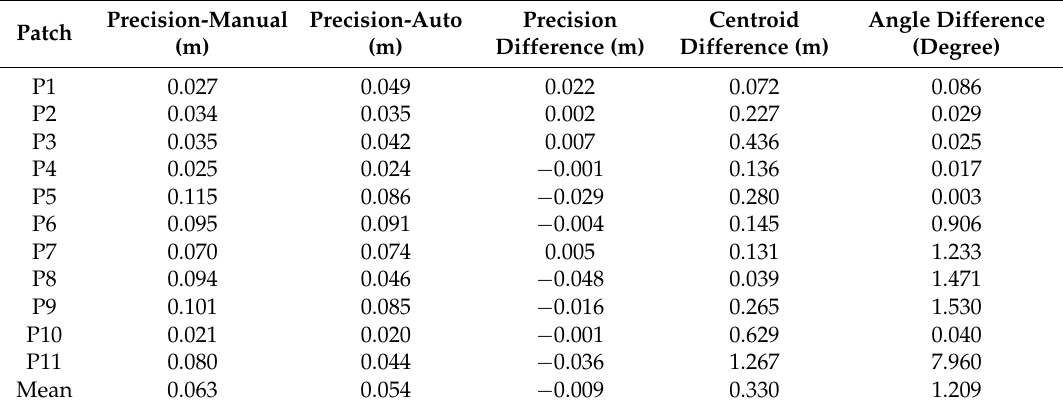
Table 8. Plane fitting precision, plane fitting precision difference, centroid difference, and angle difference values for building #3 (Adaptive cylindrical approach).